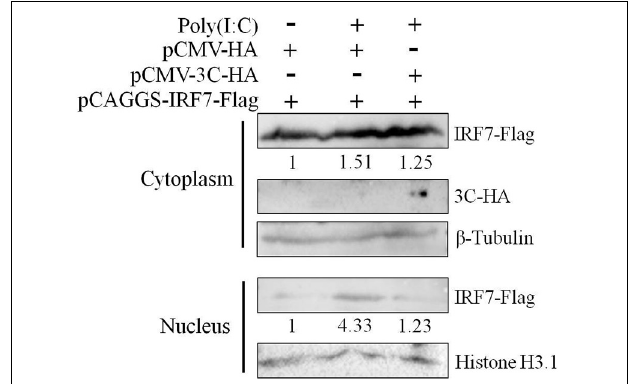
FIGURE 4 | Effect of the 3C protein on nuclear translocation of the IRF7 protein. HEK293T cells were divided into three experimental groups. The first group was transfected with 0.5 µ g of pCAGGS-IRF7-Flag and 0.5 µ g of pCMV-HA, the second group was transfected with 0.5 µ g of pCAGGS-IRF7-Flag, 0.5 µ g of pCMV-HA, and 1 µ g of poly(I:C); and the third group was transfected with 0.5 µ g of pCAGGS-IRF7-Flag, 0.5 µ g of pCMV-3C-HA and 1 µ g of poly(I:C). Cell samples were collected for nuclear and cytoplasmic separation at 36 h after transfection. Tubulin and